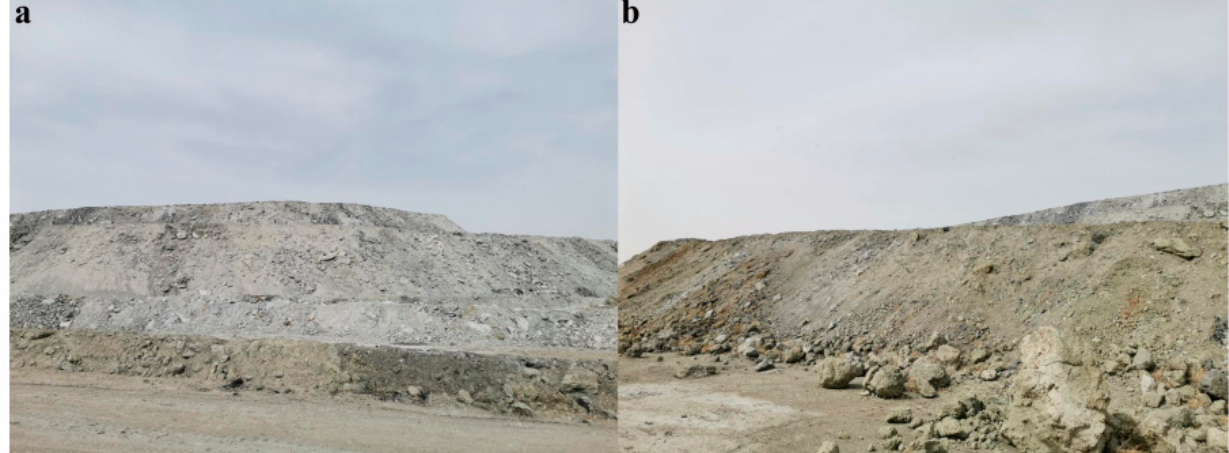
Figure 2. A large amount of spoil dumped at the periphery of the open pit after mining. ( a ) below 100 m of the pit. ( b ) soil with poor soil structure and nutrients.